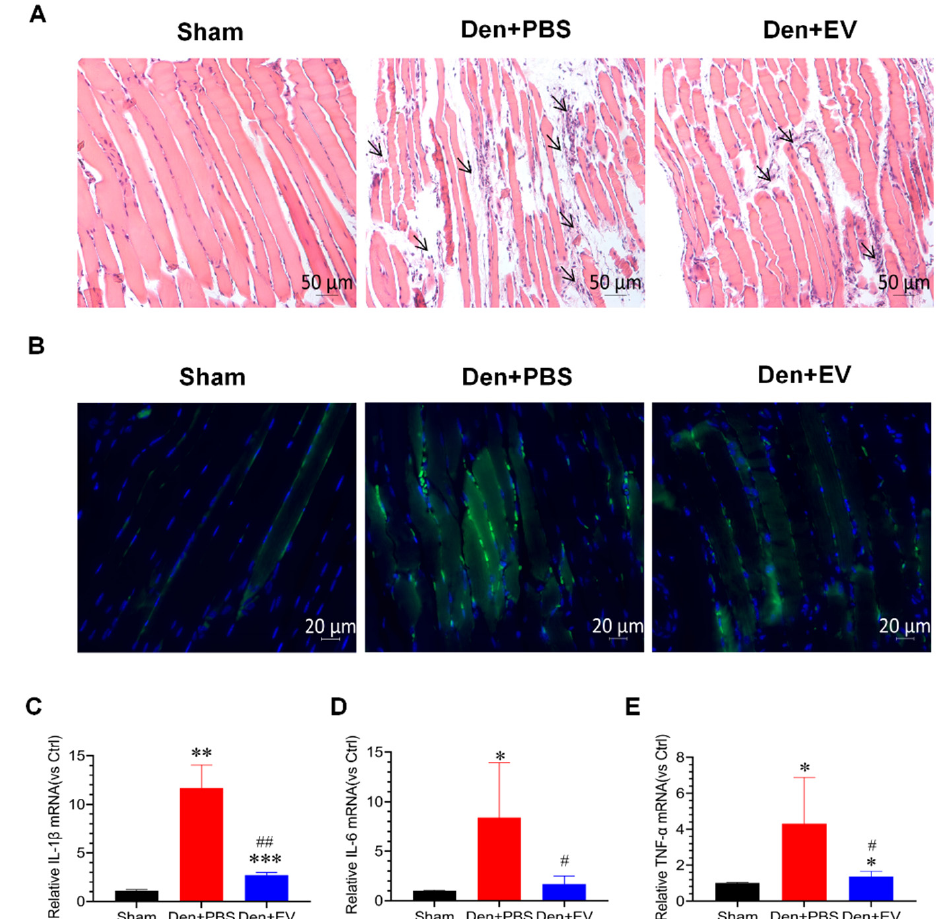
Figure 8. SKP-SC-EVs inhibit inflammation in the denervated skeletal muscle. ( A ) Hematoxylin-eosin staining of skeletal muscle. Black arrows indicate inflammatory cells. Scale bar = 50 µ m. ( B ) CD68 immunofluorescence staining (green indicates CD68 positive signals). Scale bar = 20 µ m. ( C – E ) qPCR analysis of the expression of inflammatory factors IL-1 β , IL-6, and TNF- α in the tibialis anterior muscle. n = 3, * p < 0.05, ** p < 0.01, and *** p < 0.001 vs. Sham group; # p < 0.05 and ## p < 0.01 vs.